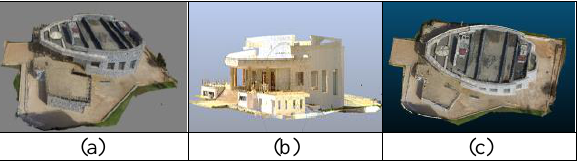
Figure 3 . Dense point clouds obtained: (a) by drone imagery, (b) by TLS, (c) Fusion of the two previous point clouds The model resulting from the drone point cloud